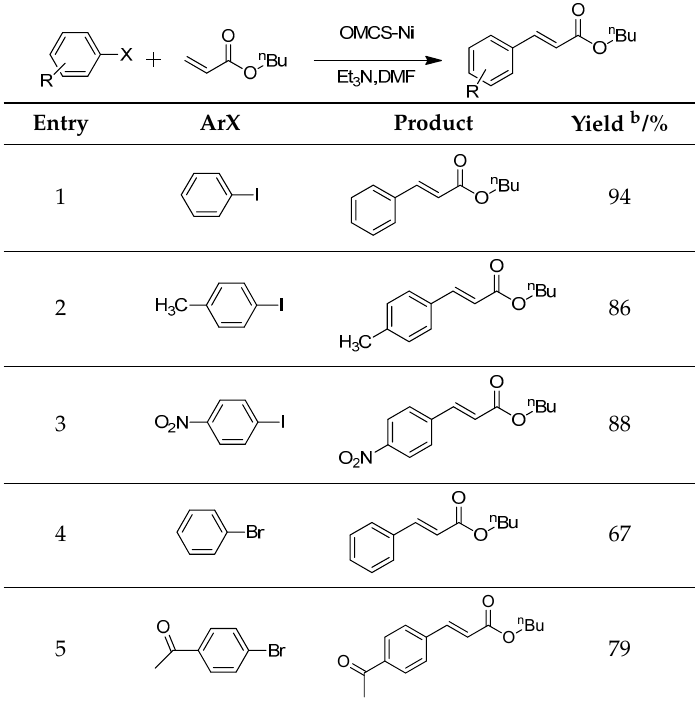
Molecules 2017 , 22 , 150